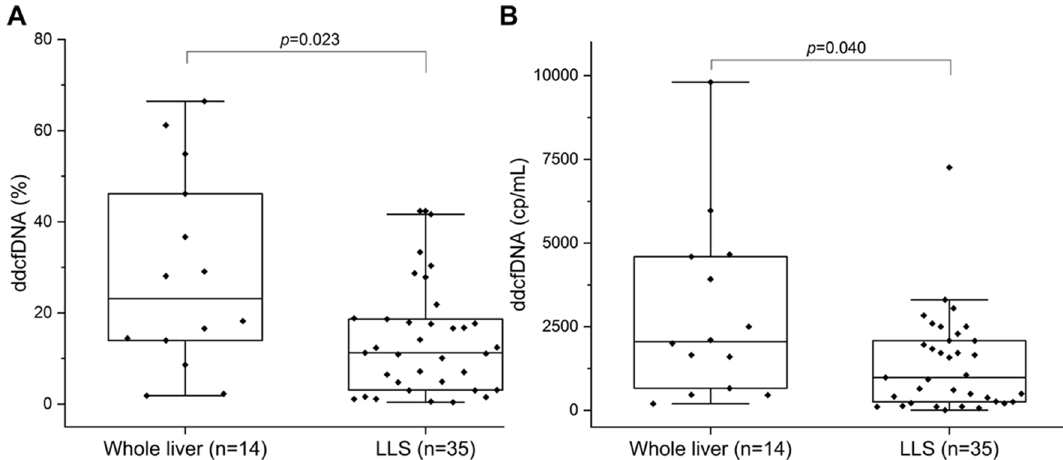
Figure 5. dd-cfDNA levels in different surgical procedures. ( A ) Box plots of plasma dd-cfDNA% in different operation types, horizontal line represents the median; bottom and top of each box represents 25th and 75th percentiles, Dots are individual values. ( B ) Box plots of plasma dd-cfDNA (cp/mL) in different operation procedure. LLS left lateral